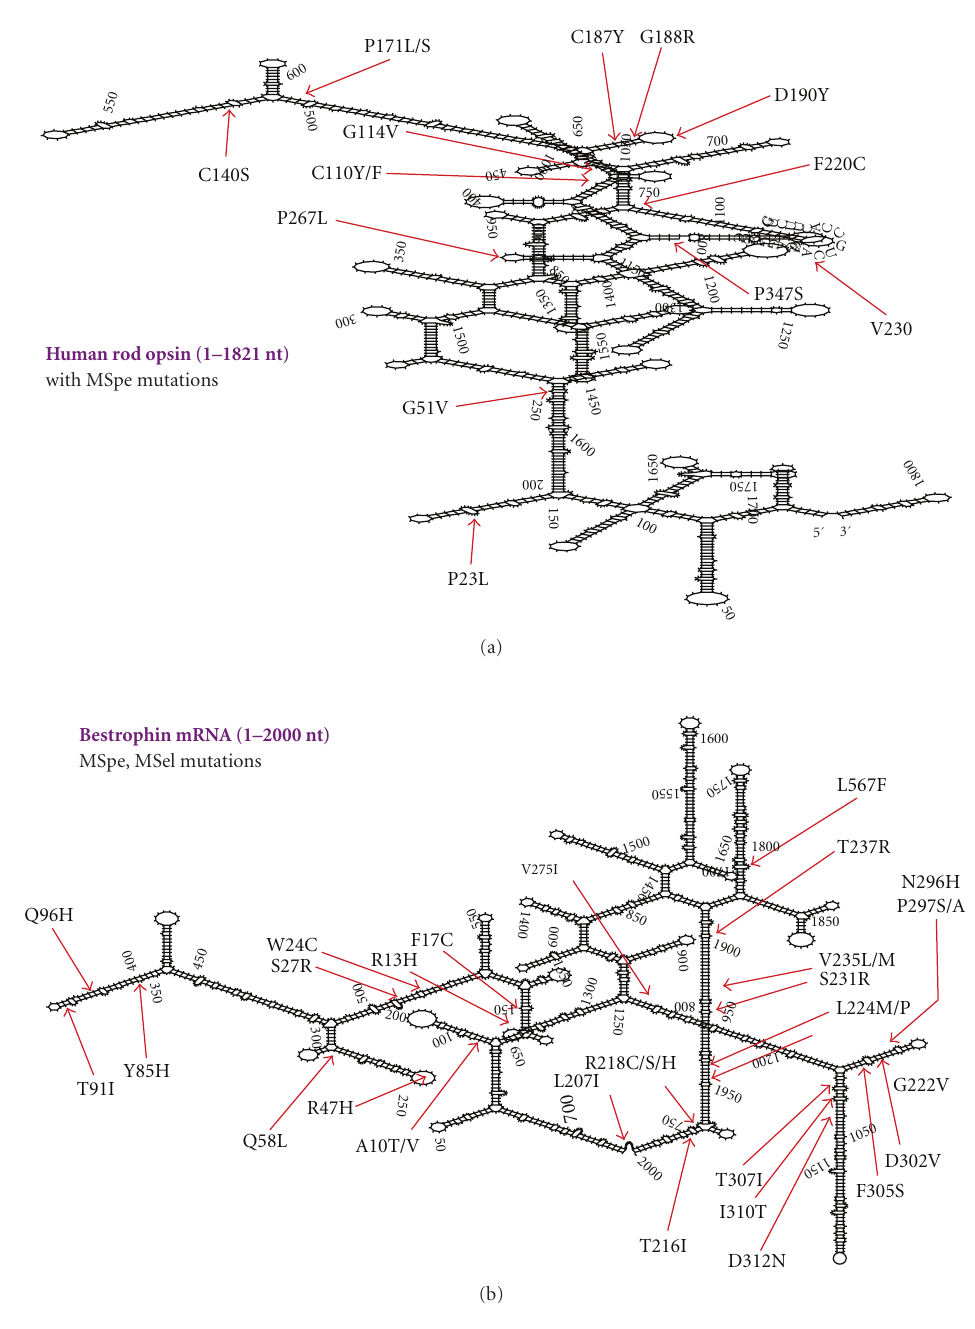
Figure 5: Predicted minimal free energy folding structures of human rod opsin and Bestrophin-1 mRNAs. GeneBank accession numbers for human rod opsin mRNA (NM000539.2) and Bestrophin-1 mRNA (NM004183) are indicated. (a) Human rod opsin mRNA (1–1820 nt) was folded in silico with RNA-Fold. The minimal free energy structure is shown. Note the dense secondary structure with only rare single- stranded annealing platforms of any substantial size. Also shown are the locations of human missense mutations that cause autosomal dominant retinitis pigmentosa and that generate new hhRz cleavage sites. These are mostly buried in secondary structure, where they would be poor targets for a mutation-specific (MSpe) approach to gene therapy as the PTGS agent would have limited capacity to anneal and cleave only the mutant target mRNA. (b) Human bestrophin-1 mRNA (1–2000 nt) was folded with RNA-fold and the MFE structure is shown. Again, secondary structure is dense with rare single-stranded annealing platforms larger than 10 nt. The locations of human mutations that cause autosomal dominant best macular dystrophy and that generate new hhRz cleavage sites for a mutation-specific strategy are shown (MSpe). Most are buried in dense secondary structure, where they would be expected to be inaccessible to annealing of a PTGS agent. Also shown are some mutations located in regions of WT cleavage sites, where they would permit a mutation-selective (MSel) approach to PTGS gene